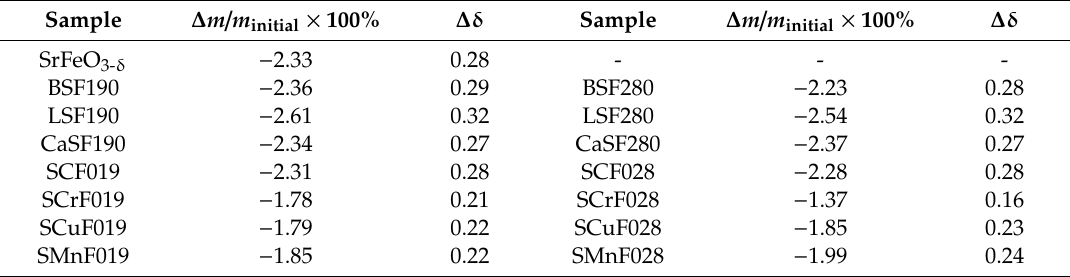
Table 2. Relative mass changes and deviation from stoichiometry changes for A- and / or B-site substitutions in SrFeO 3 − δ for TGA Screening 1 with temperatures between 573 and 1373 K in 20% O 2 / Ar.